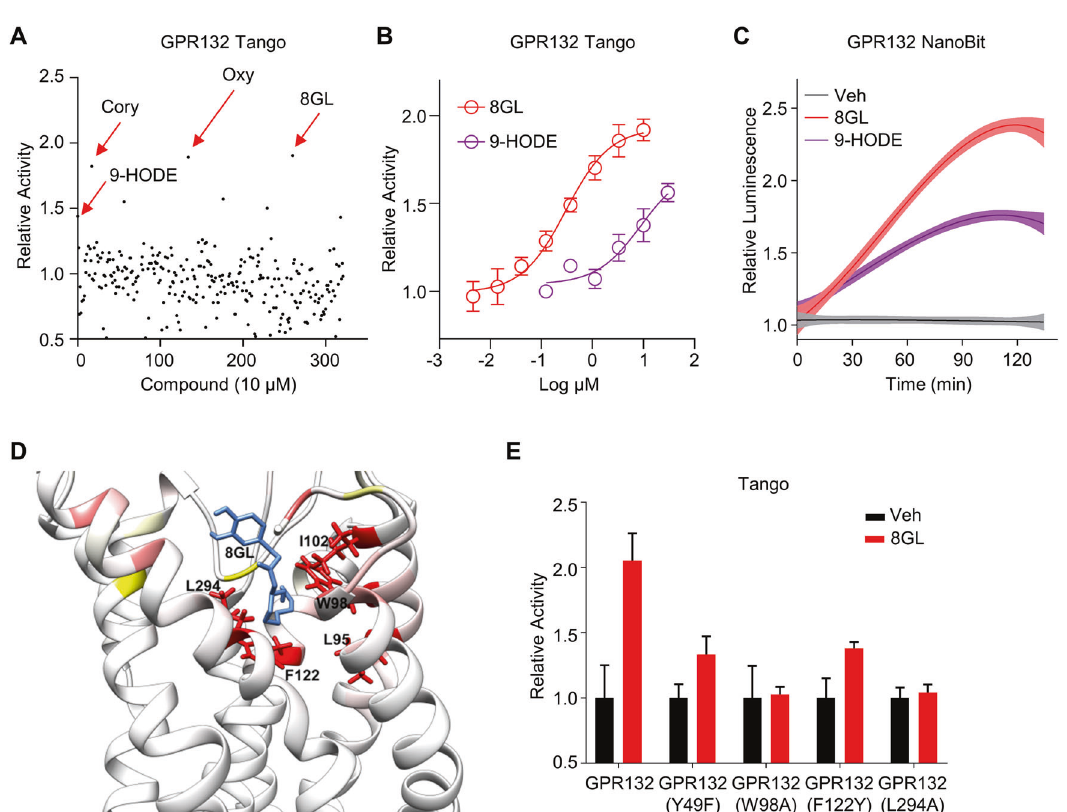
Fig. 3 Screening and validation of 8GL as a GPR132 agonist. A Dot plot showing screening results of 322 compounds evaluated with a concentration of 10 μ M in a GPR132 Tango assay. Each dot represents one compound. The top three hits were 8-Gingerol (8GL), oxyresveratrol (Oxy), and corynoline (Cory). B Dose – response curve of 8GL and 9-HODE for GPR132 activation (EC 50 = 0.30 μ M) in Tango assays. Data are shown as means ± SEM ( n = 3). C Kinetic curves of 8GL (10 μ M) or 9-HODE (10 μ M) in GPR132-NanoBiT assays using GPR132-HEK293 cells. Luminescence signals were measured at 40-s intervals. D Predicted binding mode involving 8GL and GPR132. E Agonistic activity of 8GL for wild-type GPR132 and mutant GPR132 in Tango